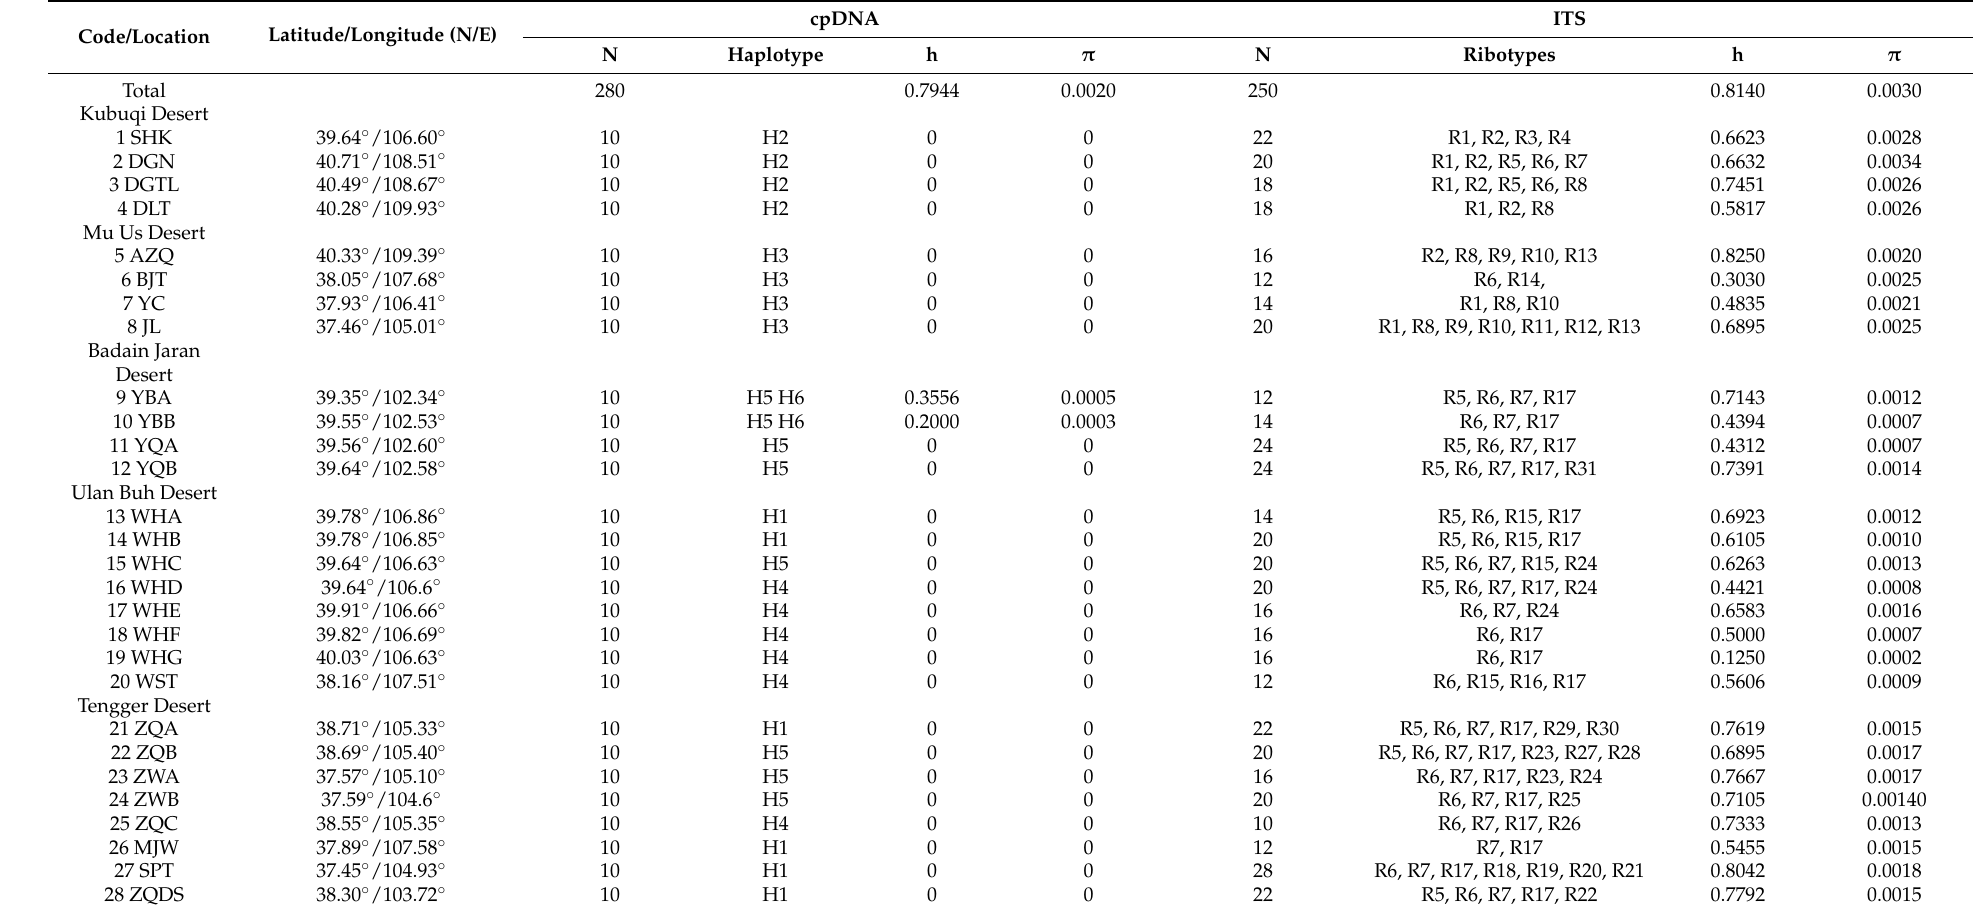
Table 1. Summary of the 28 Stilpnolepis centiflora populations’ sampling information and genetic diversity based on chloroplast DNA (cpDNA) and internal transcribed spacer (ITS) data. See Table S4 for details of the different haplotypes and